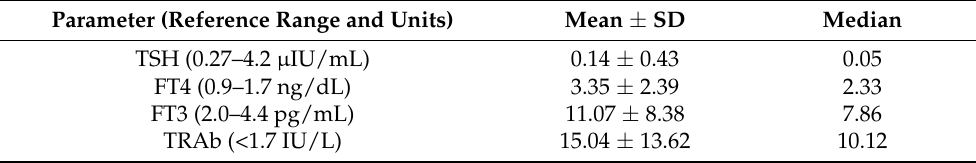
Table 1. Laboratory characteristics of the Graves’ disease (GD) group.